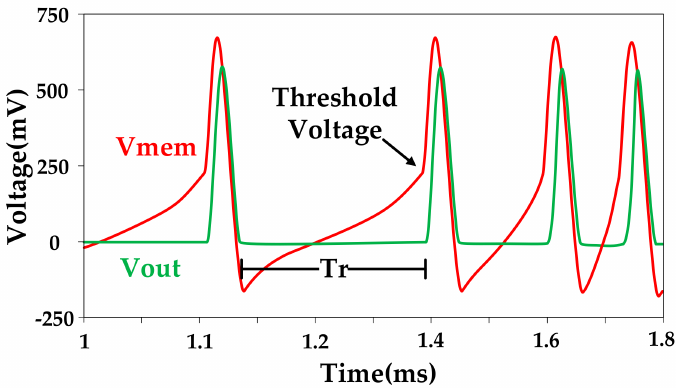
Figure 6. The schematic diagram of the operation process of the artificial neuron. V mem is the voltage of the membrane capacitor. V out is the output of the artificial neuron. Tr is the time of the resting state.